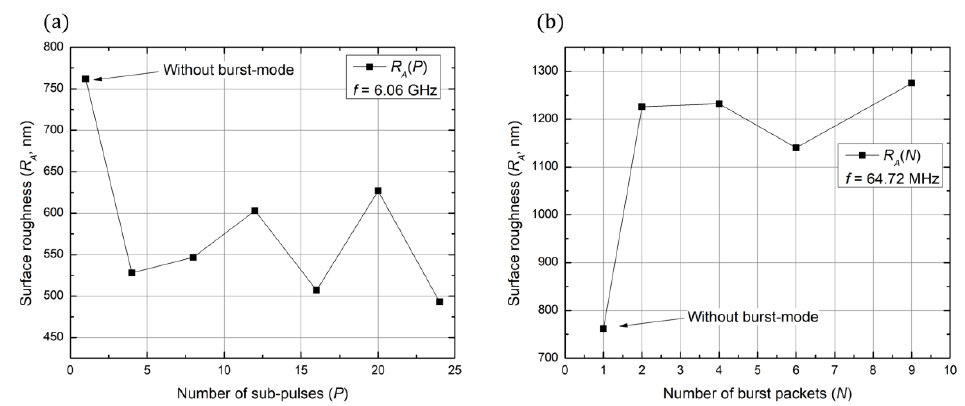
Figure 5. ( a ) Graphically depicted observed surface roughness values by changing sub-pulse number; ( b ) graphically depicted observed surface roughness values by changing the number of burst packets.